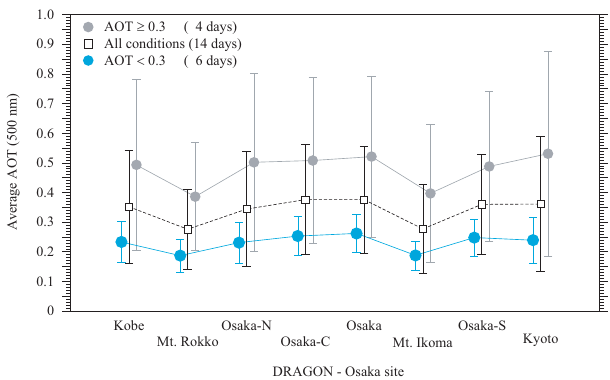
Figure 5. Daily average values of AOT (500nm) at each site, clas- sified into three cases, namely turbid days (AOT ≥ 0.3) denoted by solid gray circles, moderate days (AOT < 0.3) by light blue cir- cles, and the values obtained during the DRAGON period by white squares. The error bars represent the standard